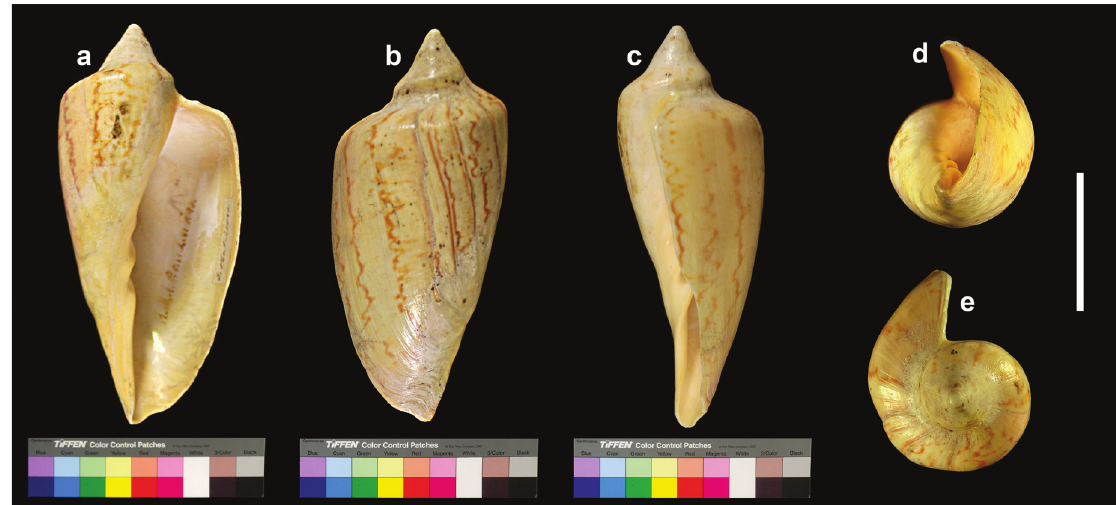
Figure 25. Voluta angulata ventricosa , specimen figured by Lahille (1895: pl. VI, fig. 93). a Apertural view b Dorsal view c Lateral view d Umbilical view e Apical view. Scale bar: 5